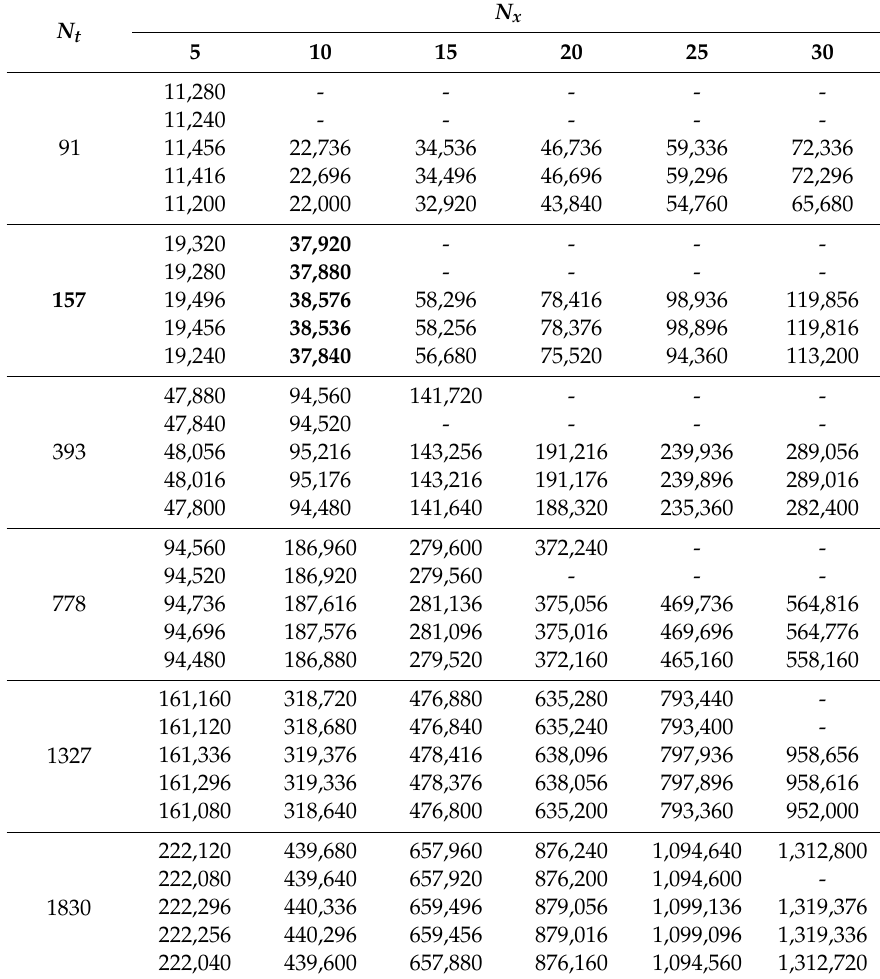
Table A1. Comparisons of demanded memory (bytes) for used di ff erence schemes and the generation method. N